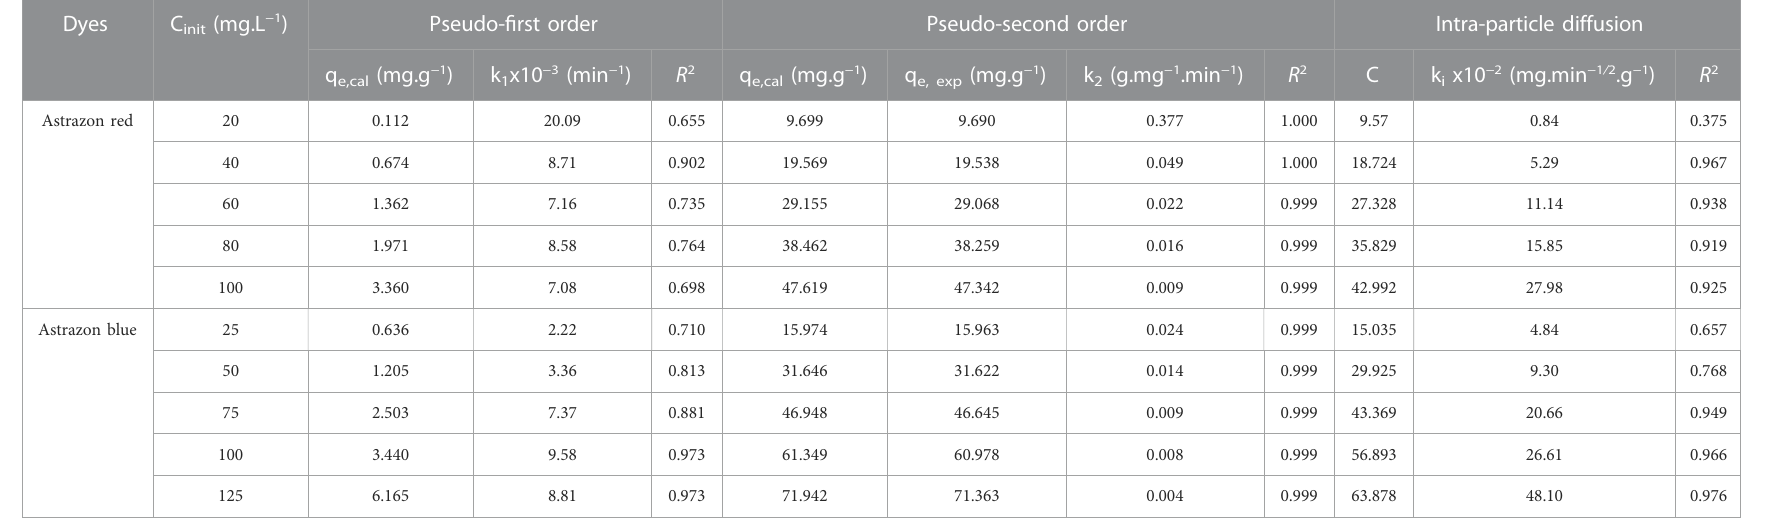
TABLE 2 Kinetic values calculated for adsorption of the textile dyes onto clay.